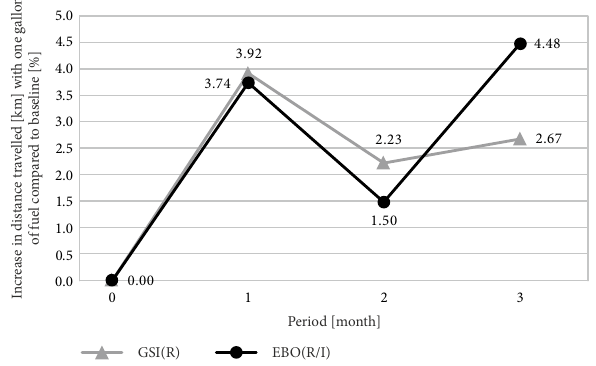
Figure 5. Increase in distance travelled with one gallon of fuel (months